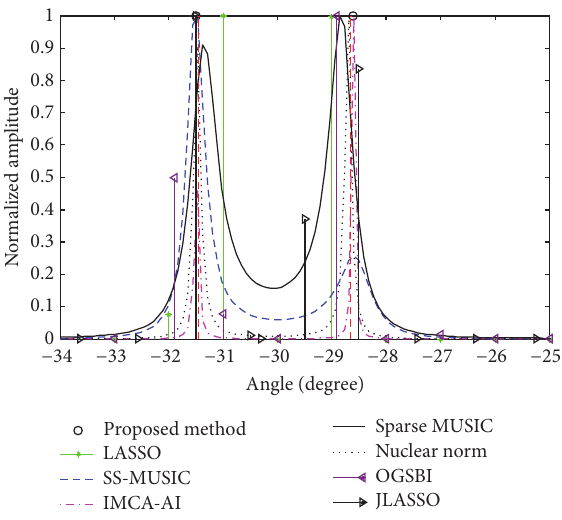
Figure 3: Resolution performance (SNR = 0 dB, 𝜆 𝑡 = 0.25 )